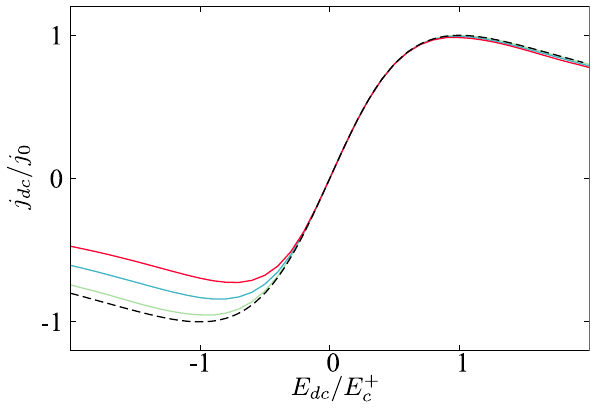
Figure 7: The current-voltage characteristics calculated fordifferent values of the asymmetry parameter, from bottom (dashed) to top δ = 1, 1.05, 1.2, 1.4. The connection with the relaxation rates reads Γ + (cid:2) eE + d and Γ − = Γ + / δ . The dashed curve represents the Esaki-Tsu c characteristic without taking into account the time relaxation- induced asymmetries, or in other words, δ =